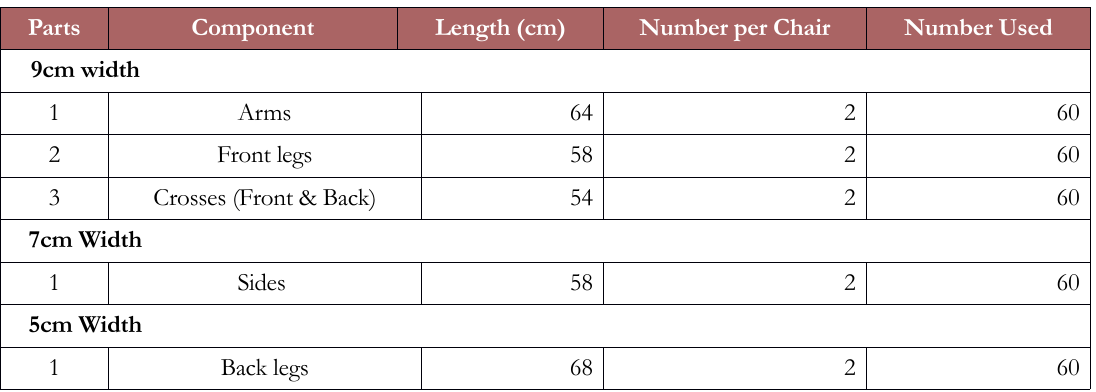
Table 4. Details of Parts list of the conference chair